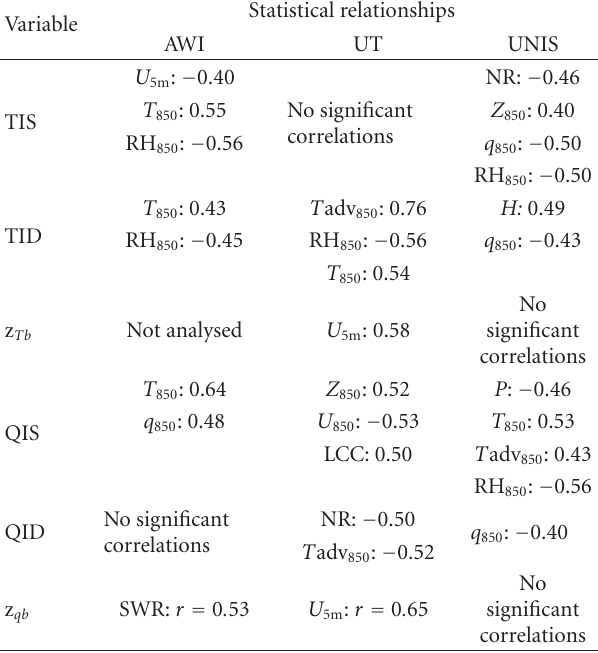
Table 4: Potentially causal variables that have highest correlation coe ffi cient ( r ) with the properties of inversions and low-level jets. Only | r | ≥ 0 . 4 with significance level exceeding 95% are